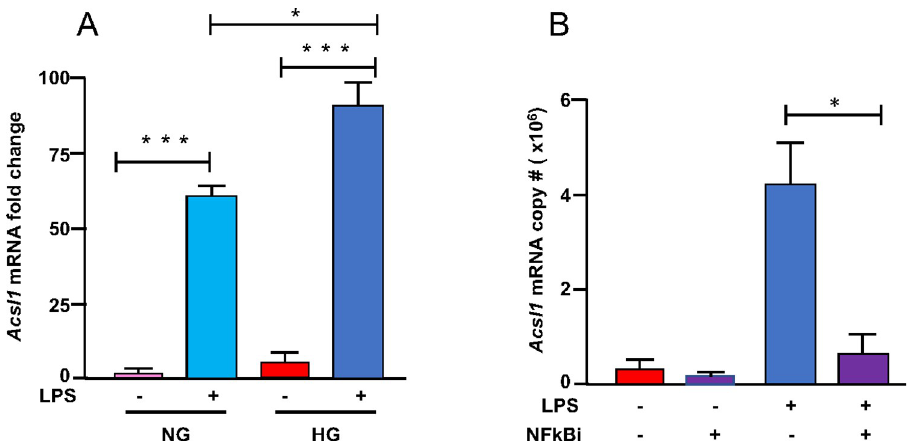
Fig 3. LPS inductionof Acsl1 expressionviaNF-kappaB. A)BMDMsweredifferentiated underNGand HGconditions. Cellswerestimulated withLPS(10ng/mL)for 24hours. TotalRNAwas isolated,and Acsl1 mRNAwasdeterminedbyqPCR relativeto cyclophilin A1and shownasfoldchange.NGtreatedsample(M0)was setto 1.B) BMDMsweredifferentiated in HG.Cellswerepretreated for 4hourswithNF-kappaB inhibitorCAPE(5 μ M)andthentreatedwithLPSfor 16 hours.RNA was isolated,and Acsl1 mRNAcopy numberwasdeterminedbyqPCR.The datapresentedaremeans ± standarderror (n= 3); thep-valuewas calculated using one-way ANOVA(p < 0.05; �� p < 0.01;and ��� p < 0.001).